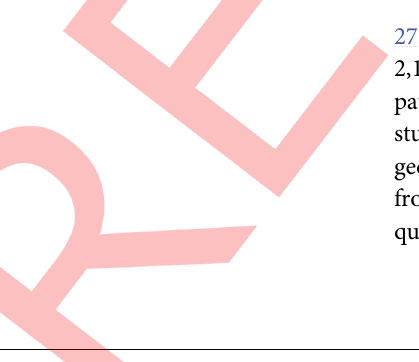
Fig 1. Flow diagram showing study retrieval and selection